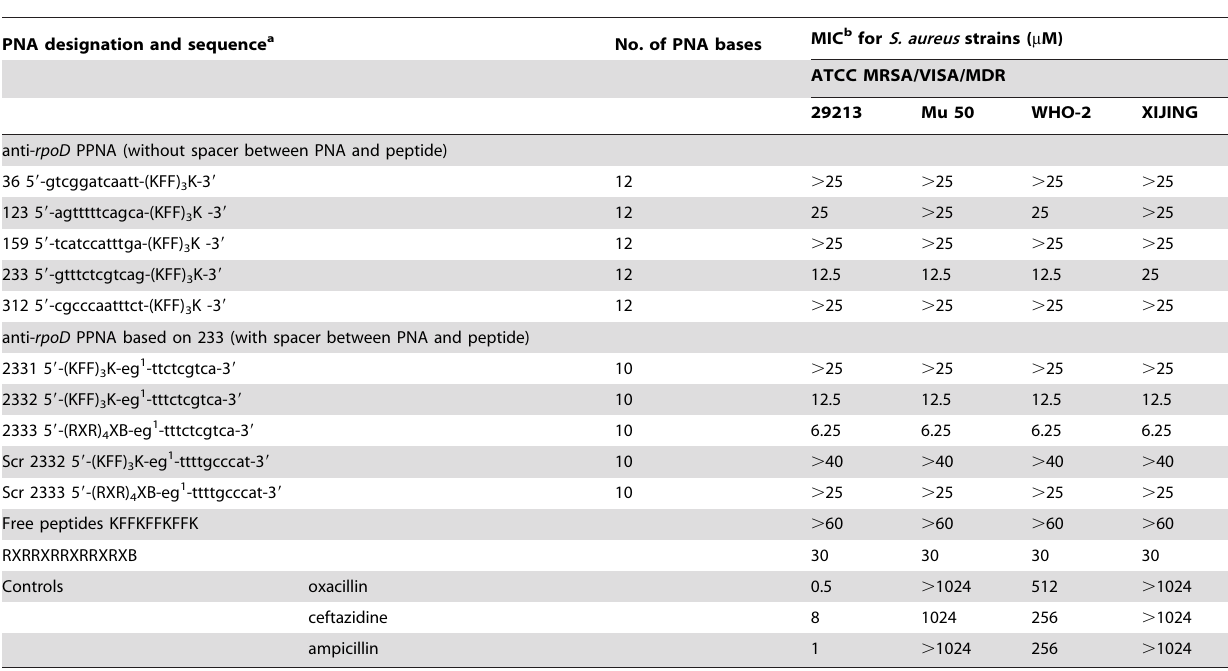
Table 3. MIC of anti- rpoD peptide-PNAs for quality control and clinical strains of Staphyloccus aureus in M-H broth culture.